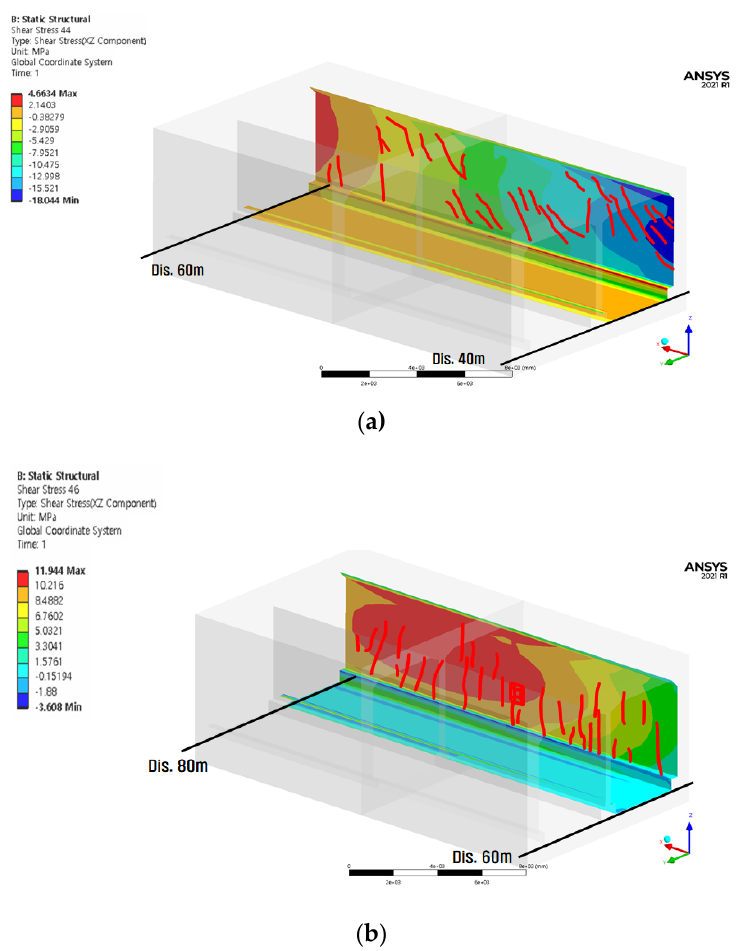
Figure 13. Comparison between the visual inspection mesh diagram and analysis results (Cell 2 wall) for the transition section: ( a ) 40–60 m; ( b ) 80–100 m.